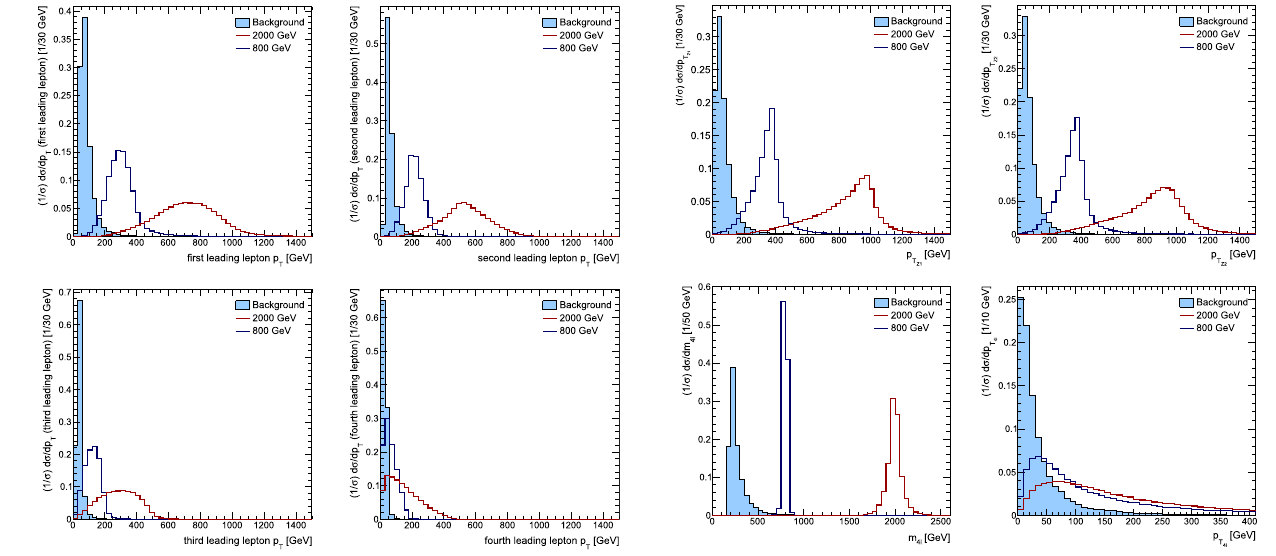
= 2000 GeV (red line), √ 2 s = 100